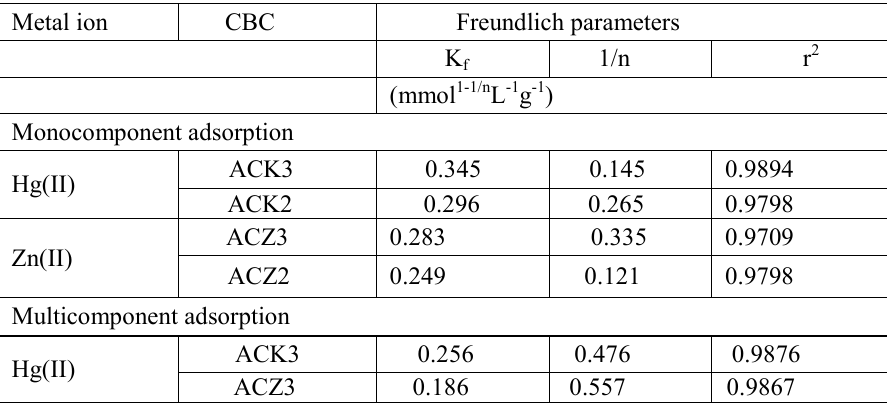
Table 3. Results of adsorption isotherms for Cu(II) and Pb(II) in monocomponent an binary